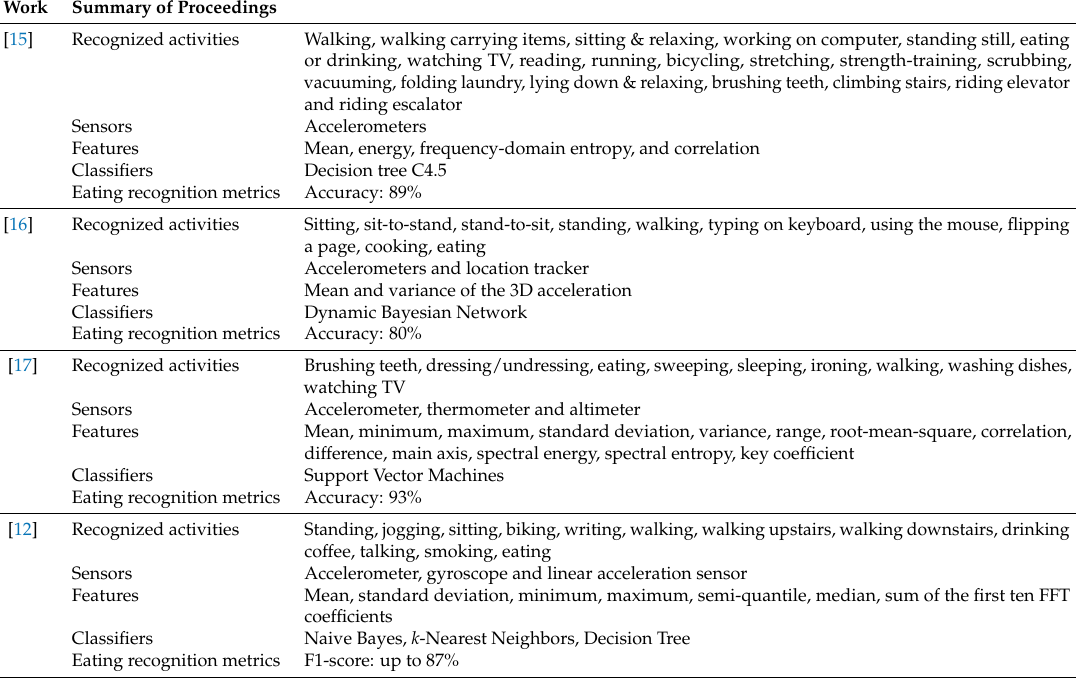
Table 1. Supervised Human Activity Recognition (HAR) works that recognize the eating activity among other Activities of Daily Living